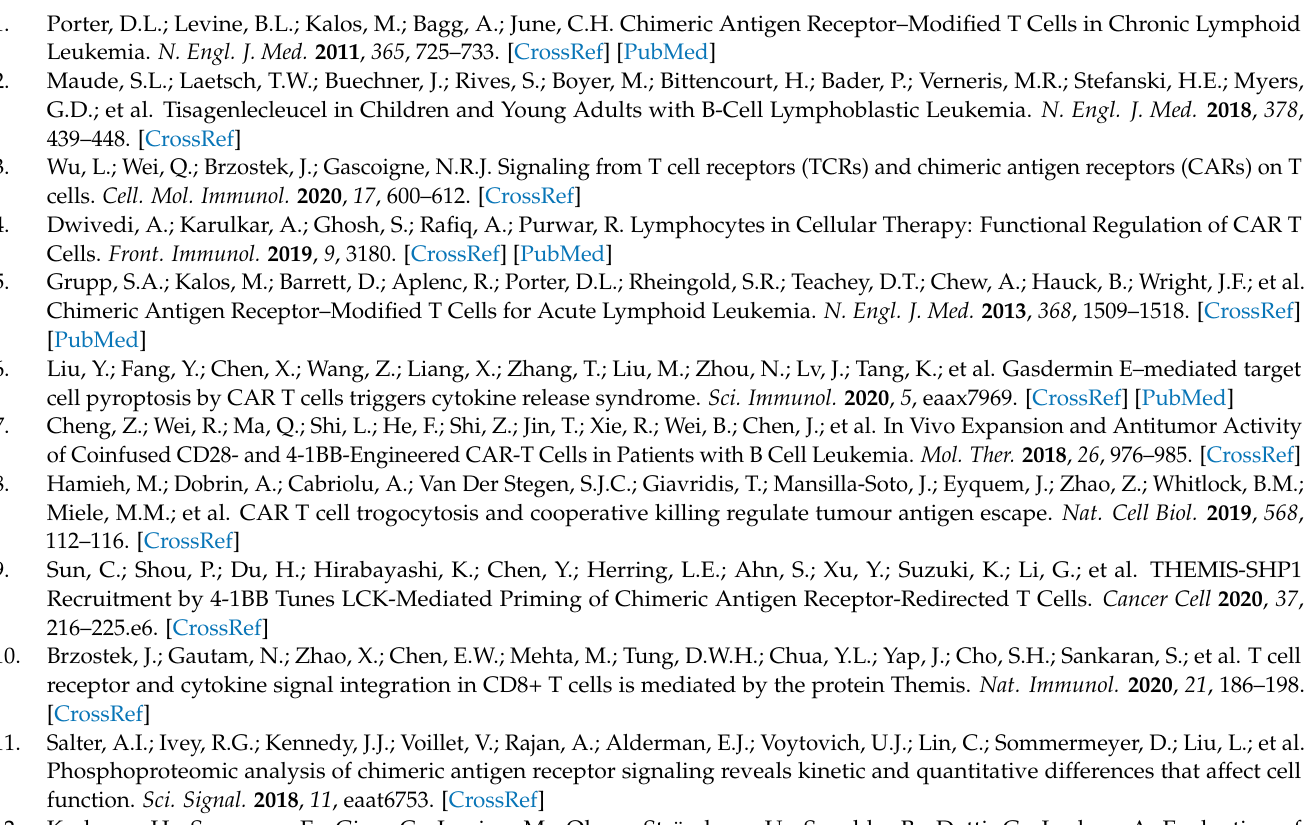
Figure S1, Figure S4: Artificial CHO antigen-presenting cells, Figure S5: CD8 recruitment to the IS and functional impact of CD8 for CAR-T and